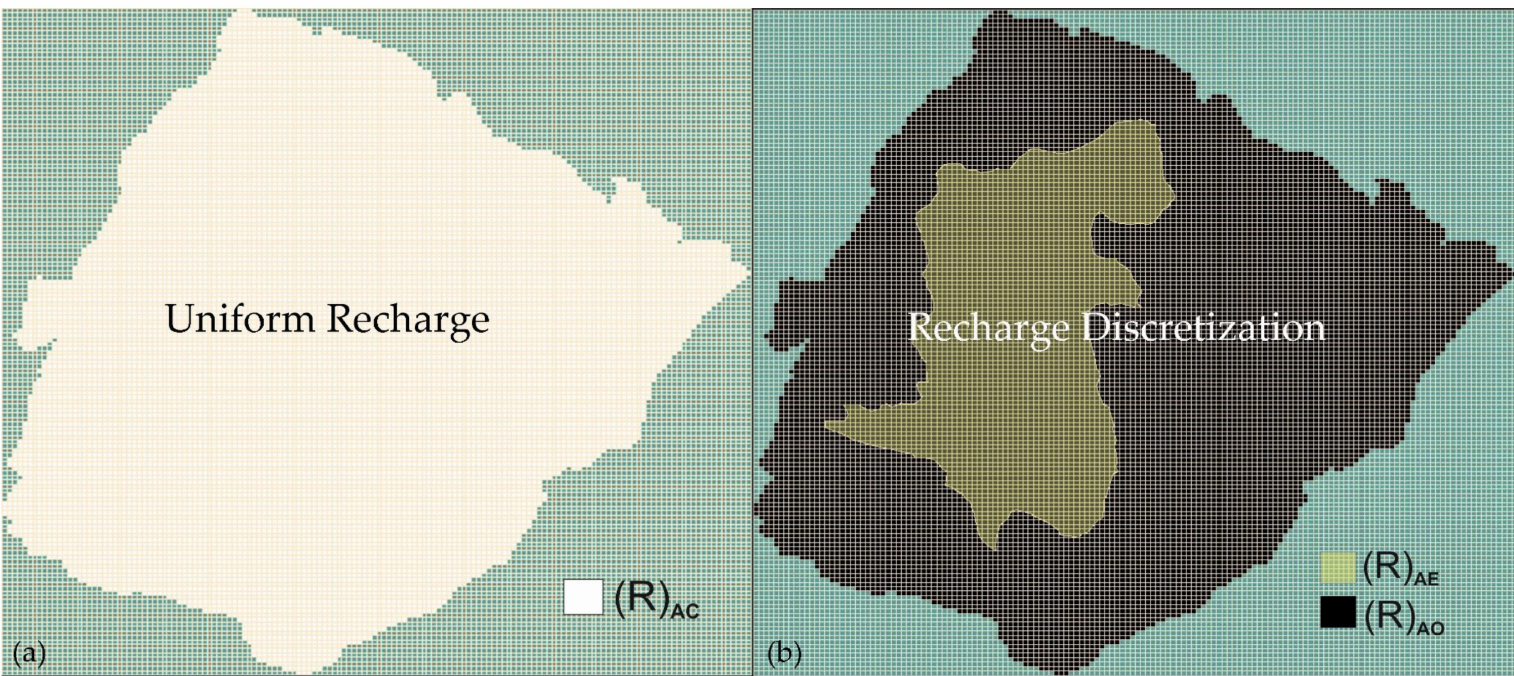
Figure 6. Workflow showing the steps followed for the groundwater flow simulation.